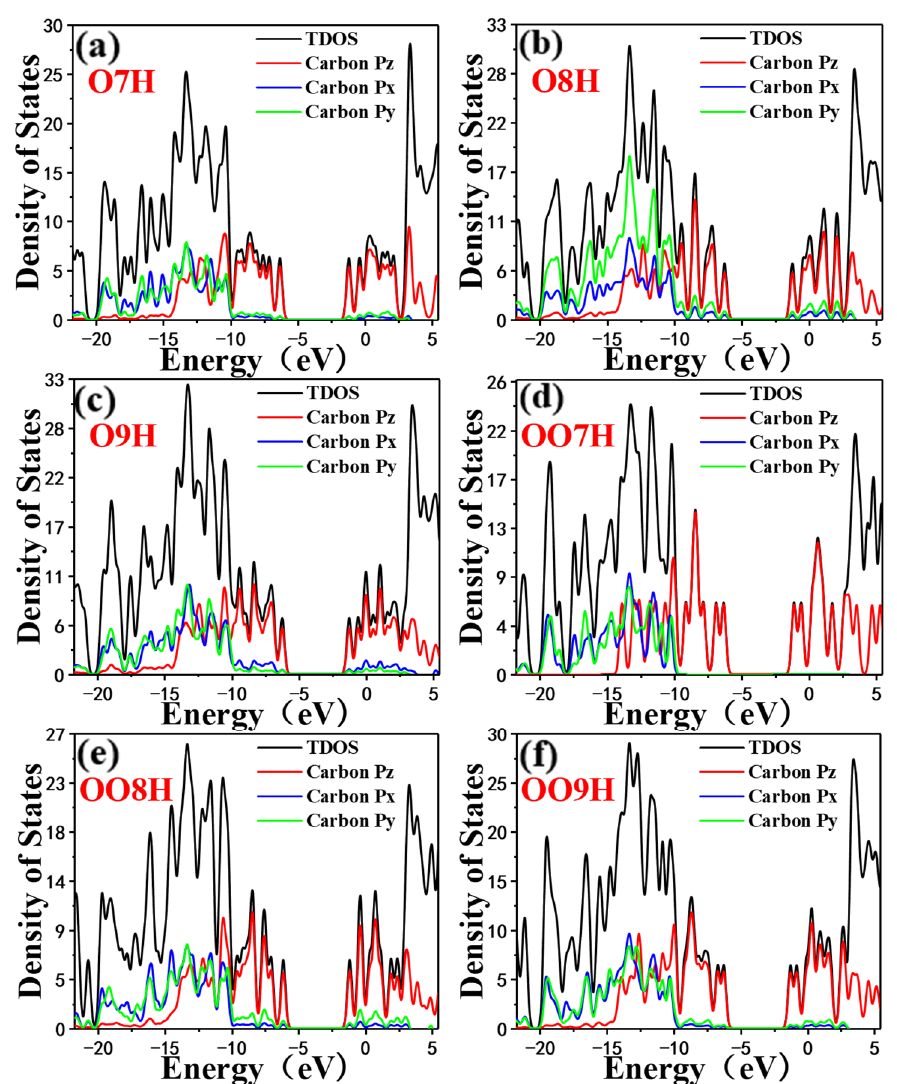
Figure 4. Density of states for the 6 molecules. The black curve is the total density of states, and the red, blue, and green curves are the local density of states on the P z , P x , and P y orbitals of carbon